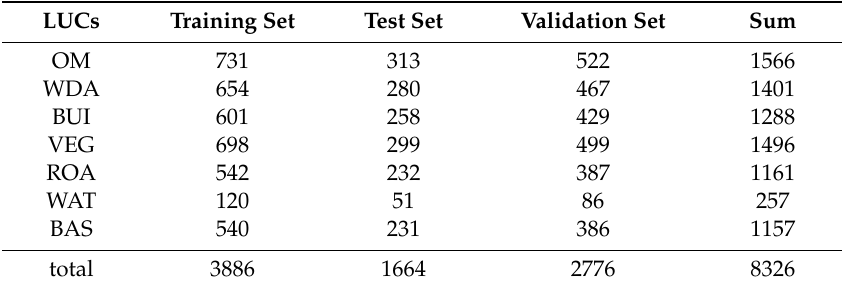
Table 3. Sample set utilized in this study. LUCs: land use